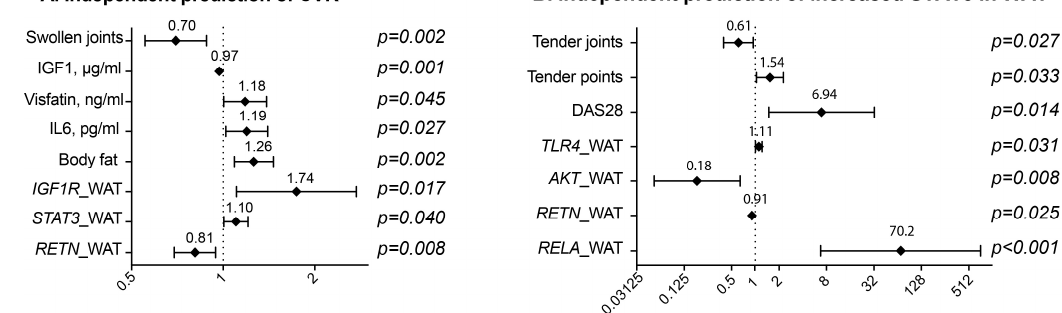
Figure 4. Parameters associated with cardiovascular risk ( A ) and with expression of STAT3 in subcutaneous adipose tissue ( B ) of patients with rheumatoid arthritis. To identify the variables predicting increased CVR, a binary logistic regression with Wald backwards elimination was performed. The presence of CVR and was set as the dependent variable in the model A. The expression of STAT3 in WAT within the upper 2/3 mRNA levels was considered increased and set as the dependent variable in the model B. Number of tender and number of swollen joints, number of tender fibromyalgia points (TP), erythrocyte sedimentation rate (ESR), disease activity score (DAS28), weekly dose of methotrexate (MTX), serum levels of IGF1, leptin, adiponectin, resistin, visfatin, IL-6, IL-1 β , percentage of the body fat, and mRNA levels of IGF1R , TLR4 , AKT1 , RETN , RELA in white adipose tissue (WAT) were introduced as independent variables in the first step of the models. The importance of each variable was verified using Wald statistics and the variables of no importance ( p > 0.1) were eliminated. The last step of the elimination analysis in the model A and model B is shown here and indicate the parameters independently associated with CVR and the increased expression of STAT3 in WAT.